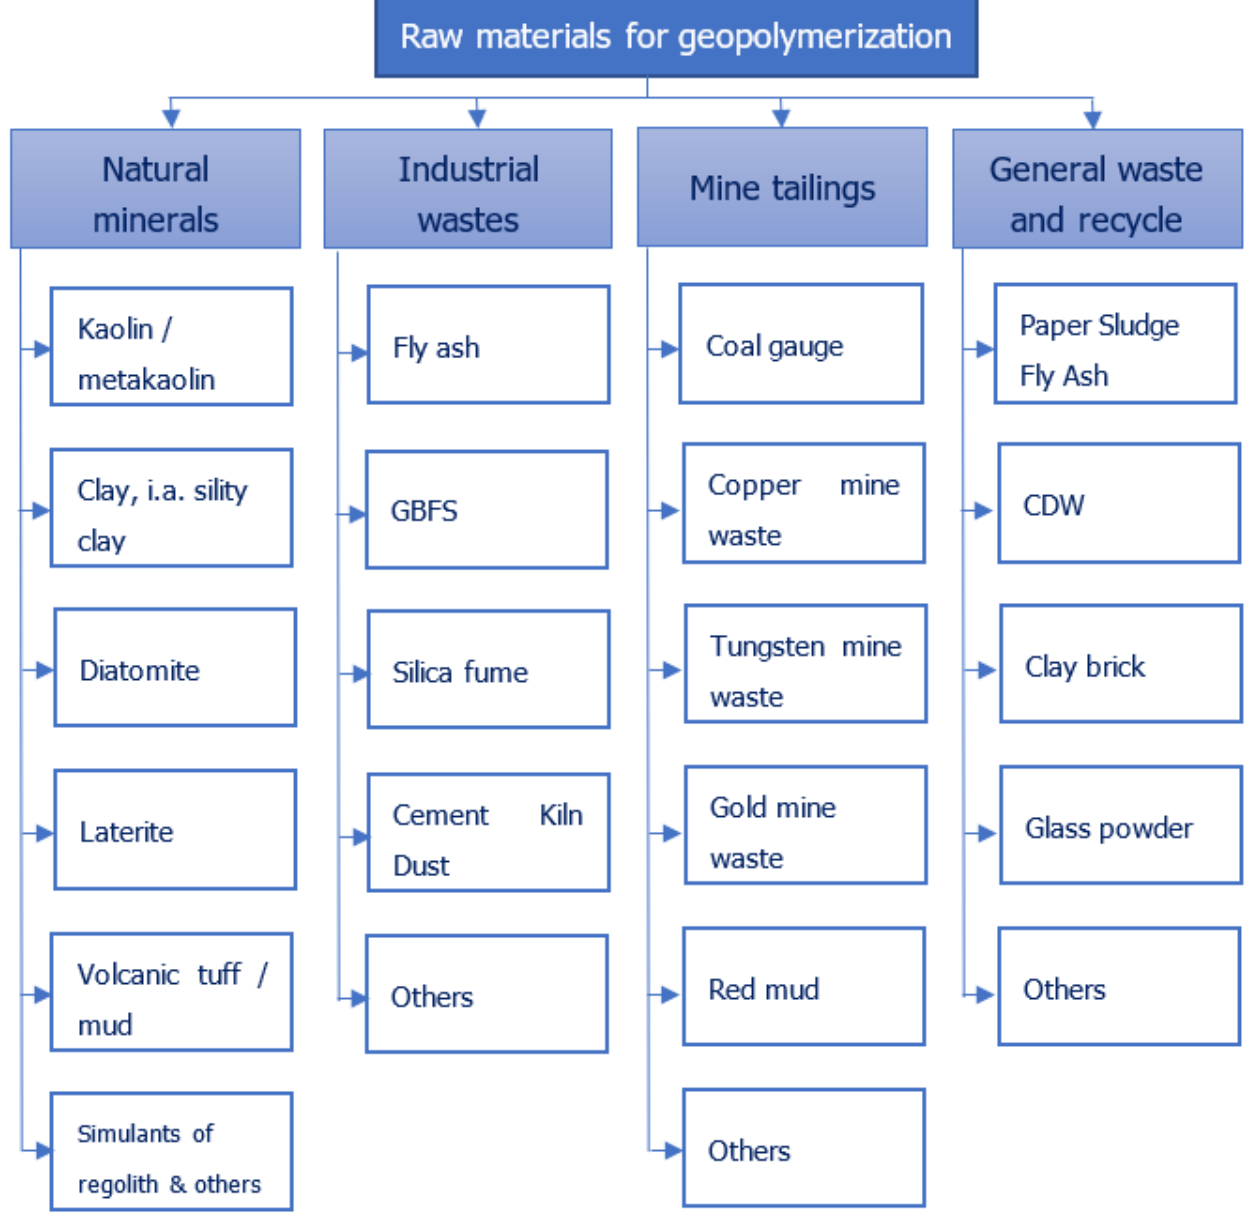
Figure 1. Raw materials used in geopolymerization as aluminiosilicate sources.